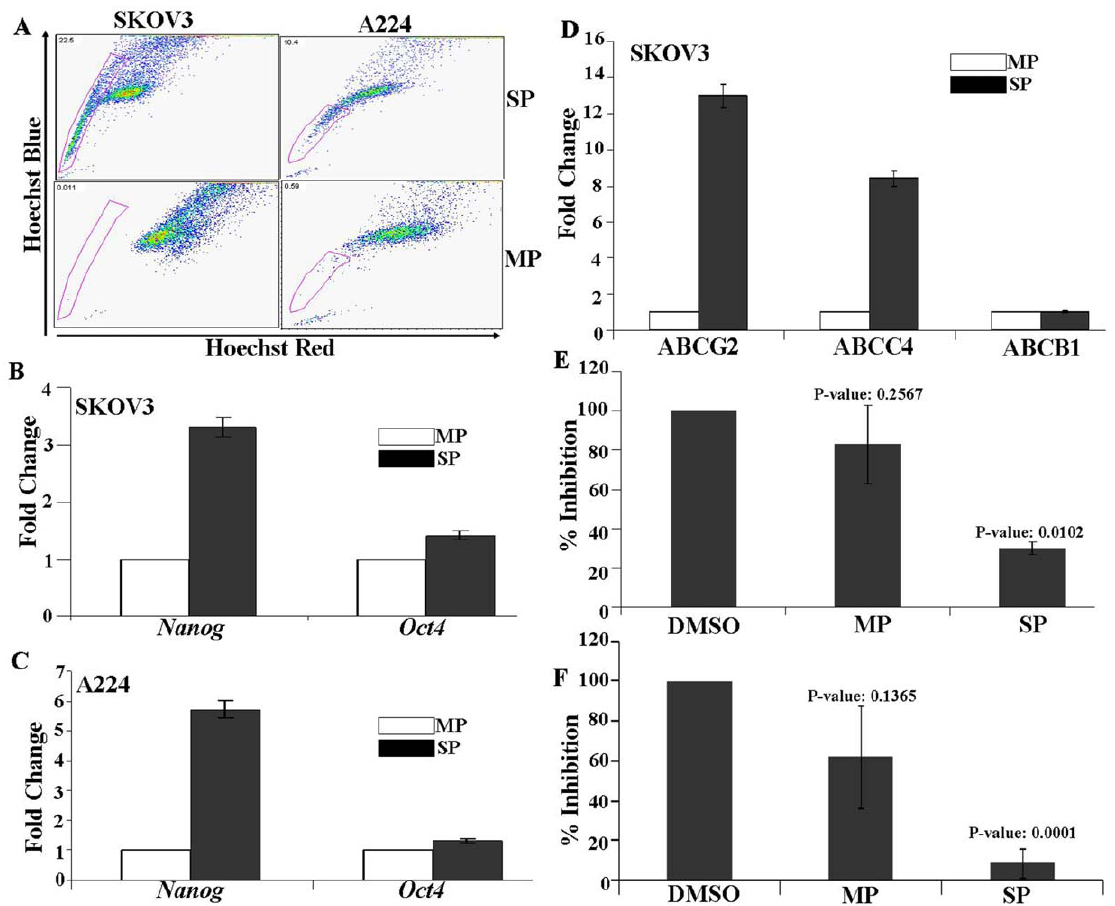
Figure 5. Validation of SP cells from cell lines and the effect of GSI-IX inhibitor on SP cells colony forming efficiency. (A) Repopulation Assay: The SKOV3 and A224 cells were stained with Hoechst 33342 dye and sorted for SP and MP populations. The cells were cultured for 8 days for repopulation, and then reanalyzed by flow cytometry. This demonstrated the enrichment of SP cells (22.5% and 10.4% for SKOV3 and A224 resp.) with a capacity to regenerate to MP cells. (B, C, D) qRT-PCR analysis for stem cell marker genes and transporter genes (p , 0.01). To calculate the relative expression for each gene, the 2 2 DD CT method was used averaging the CT values for the three housekeeping genes (Cyclophilin A, GUSB, GAPDH) for a single reference gene value. (E, F) Inhibitory effect of GSI-IX on Colony forming efficiency of sorted SP and MP cells from SKOV3. Cells were sorted to SP and MP populations and treated with 10 and 20 m g of GSI-IX. The inhibitor carrier DMSO is used as a control.